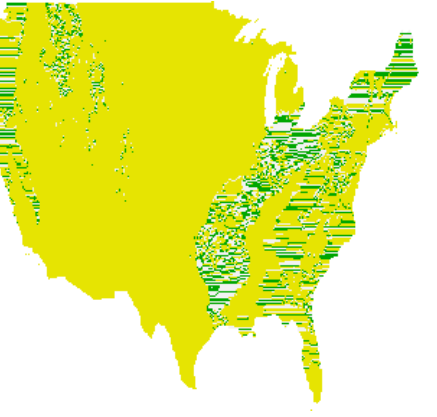
Figure 6. Comparison between precipitation divergence of west and east direction